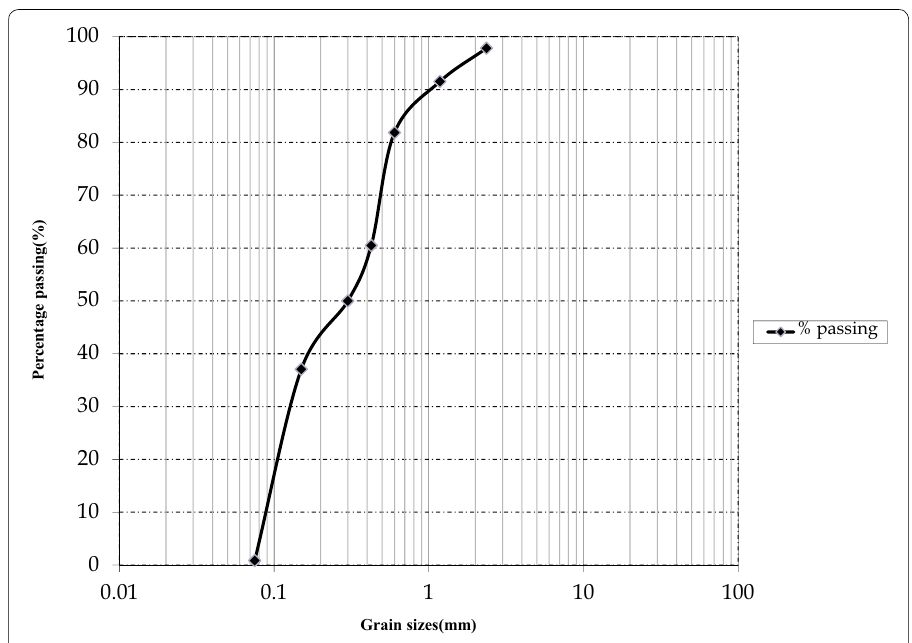
Fig. 1 Grain size analysis result for soil used in the